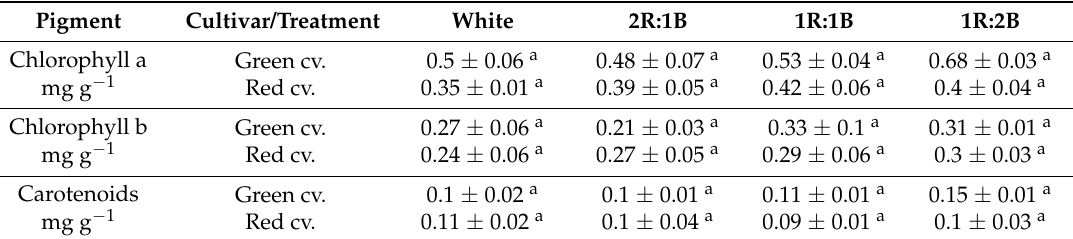
Table 2. Chlorophyll and carotenoid pigment contents in green and red basil cultivars. Pigment Cultivar/Treatment White